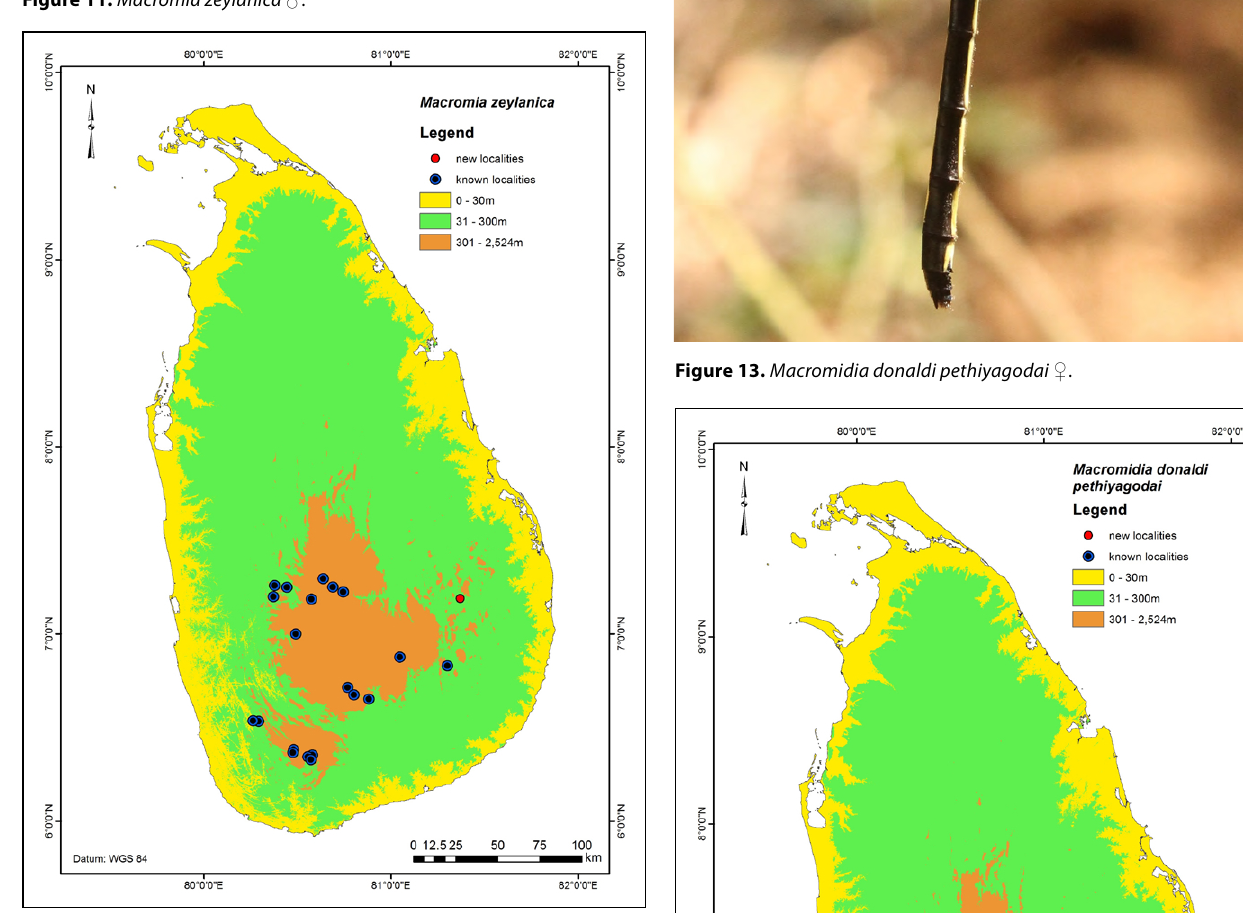
Figure 11. Macromia zeylanica ♂ .